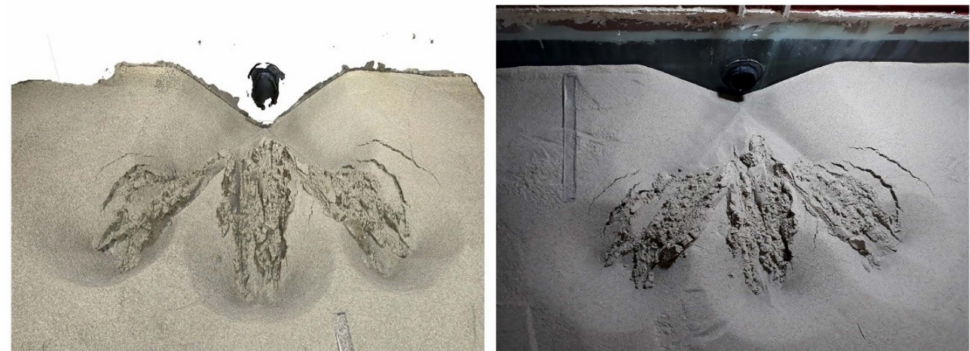
Figure 3. Three-dimensional dense point cloud in the software workspace ( left ) and real image of the sediment flushing cone ( right ).